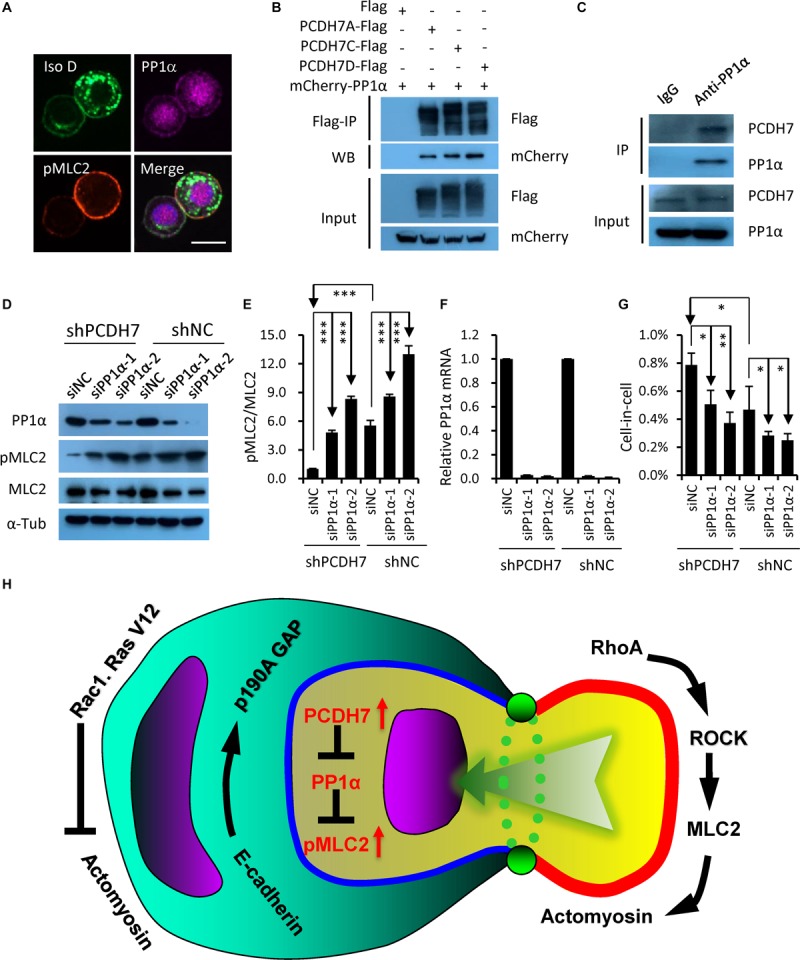
PCDH7 interacts with PP1α to inhibit homotypic cell-in-cell formation. (A) PCDH7 co-localizes with PP1α at cell-cell contact. Scale bars: 15 μm. (B,C) PP1α interacts with PCDH7 as determined by co-immunoprecipitation assay in HEK293FT cells for overexpressed proteins (B) or MDA-MB-436-2 cells for endogenous proteins (C). (D) Increased pMLC2 expression upon PP1α knockdown as determined by Western blot in MDA-MB-436 cells. (E) Quantification of pMLC2/MLC2 in (D). ∗∗∗P < 0.001. (F) Relative mRNA level of PP1α upon knockdown in MDA-MB-436 cells. Data are mean ± SD of triplicate experiments. (G) PP1α knockdown inhibits CIC formation in MDA-MB-436 cells. Data are mean ± SD of triplicate experiments. ∗P < 0.05; ∗∗P < 0.01. (H) Updated working model for entotic CIC formation regulated by PCDH7 and PP1α.